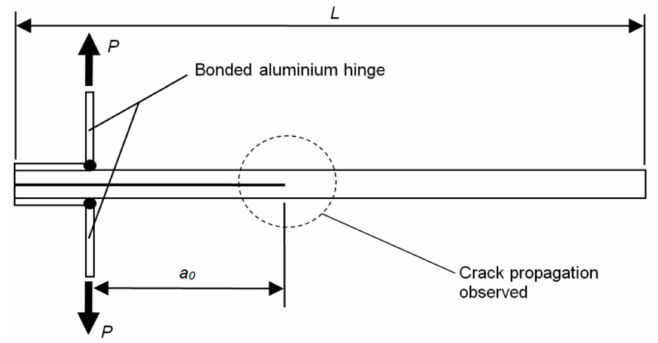
Figure 2. Double cantilever beam (DCB) specimen and loading configuration.